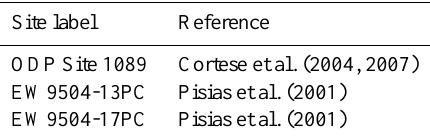
Table A3. Proxy records of SST based on the radiolaria fauna in- cluded in this study. Each record is identified by the site label.